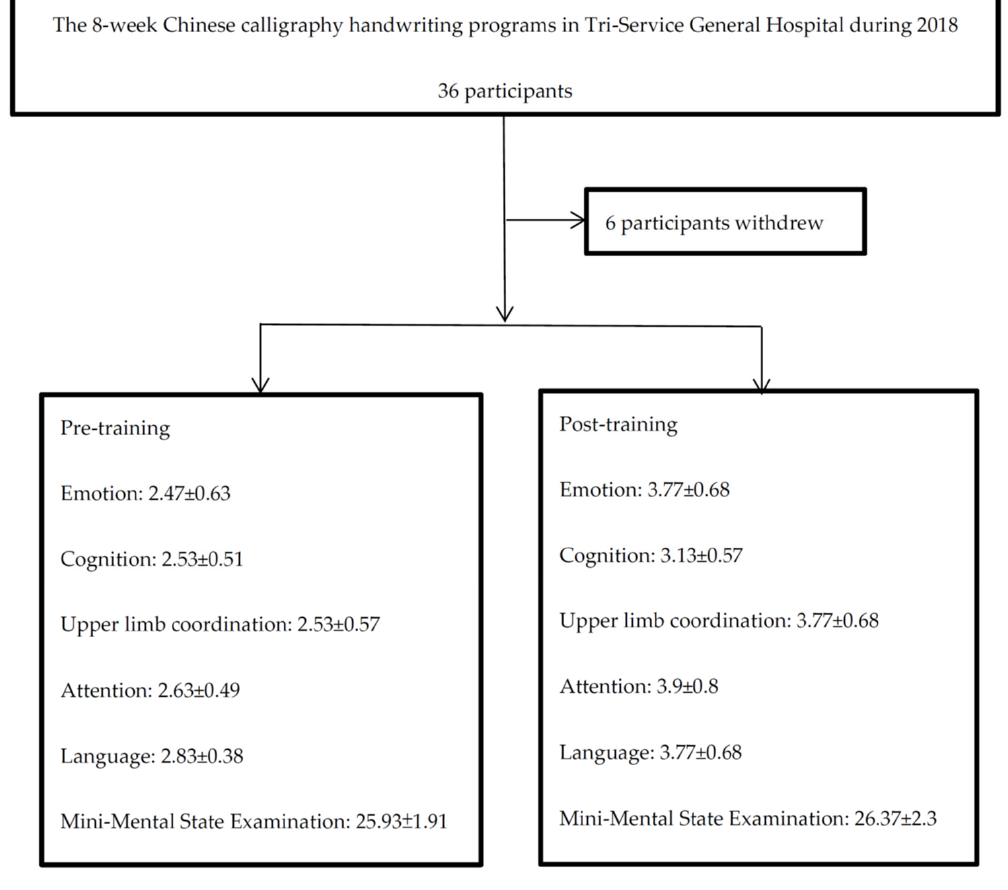
Figure 1. Flowchart of this study.